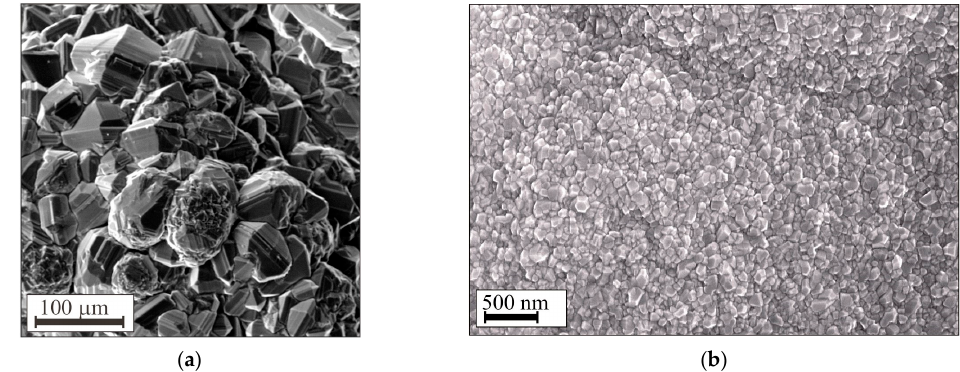
Figure 3. Gas-tight protective coatings formed by micro-F ( a ) and nanocrystals ( b ).